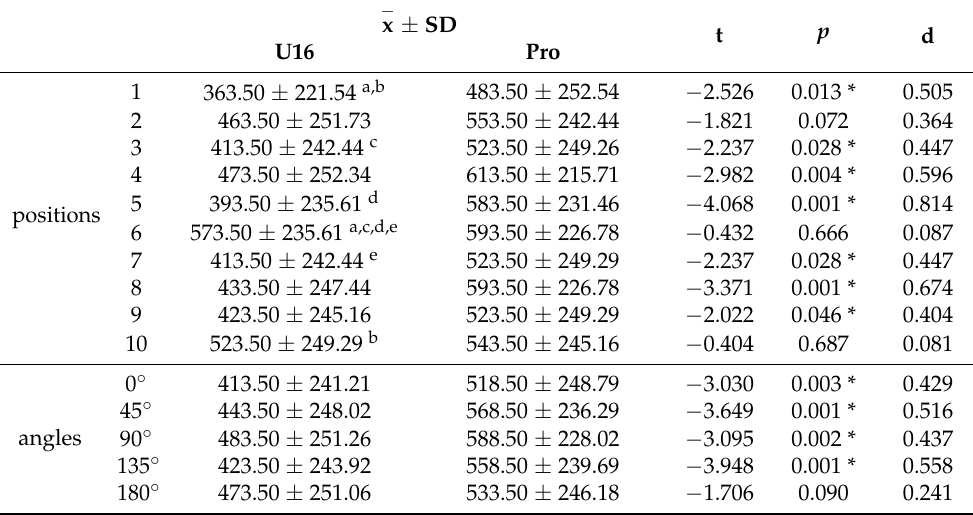
Table 1. Between-group comparison for shot efficacy, according to position and angle.